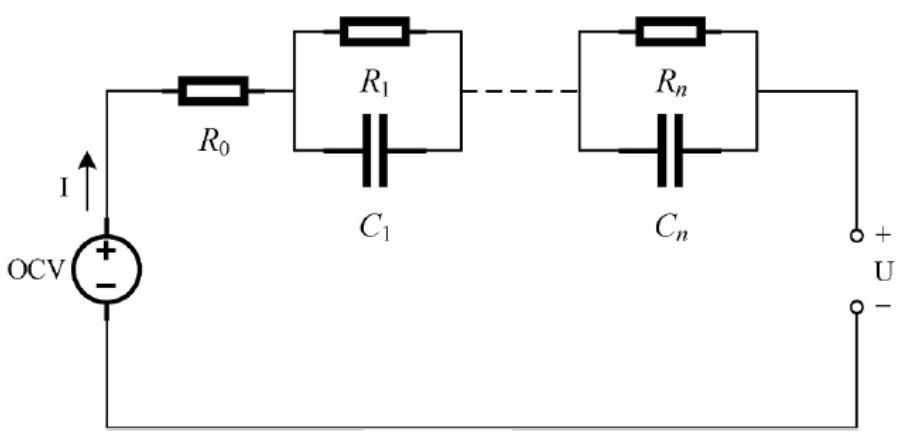
Figure 5. General equivalent circuit model [23]. Reprinted with permission from Ref. [23]. 2021, Elsevier.